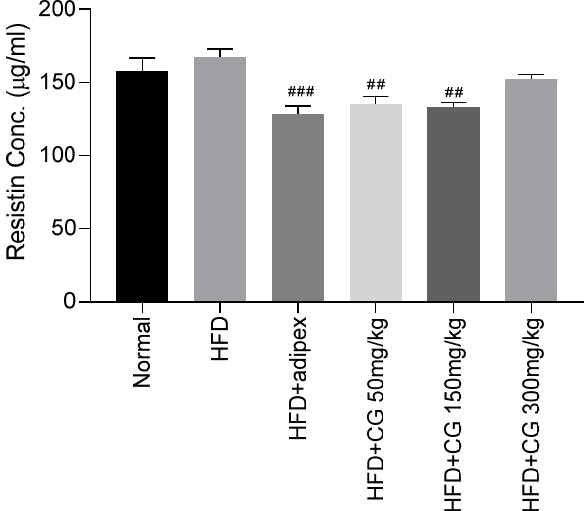
Figure 5. The results of serum resistin level of the mice. Data represent means ± S.E.M. ## p < 0.01, ### p < 0.001 compared to HFD group. ### p < 0.001 compared to HFD